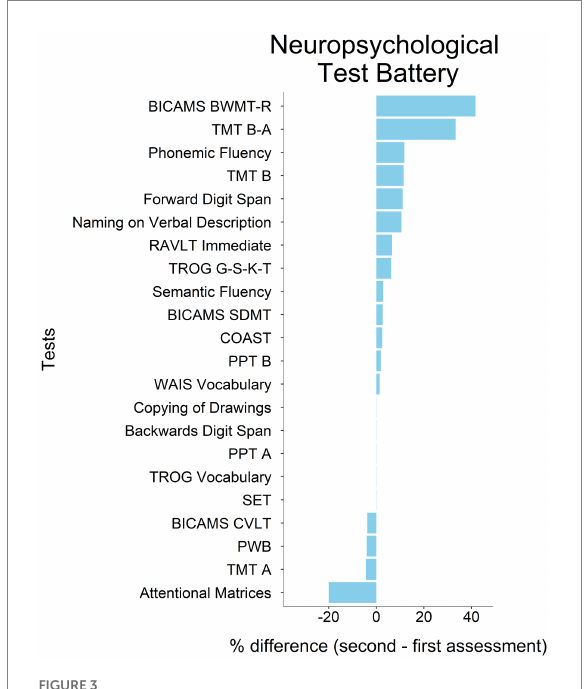
FIGURE 3 Differences in neuropsychological assessment percentage scores between first and second assessment. Raw scores have been converted into percentages following the formula: (obtained scores/maximum attainable score)*100. Tasks are ordered according to the magnitude of changes, from the most positive to the most negative. The direction of change in TMT scores has been reversed with respect to Table 1 to depict improvement and worsening straightforwardly, since a decrease in scores (negative magnitude) represents an improvement in this test. Tests’ acronyms are reported in Table